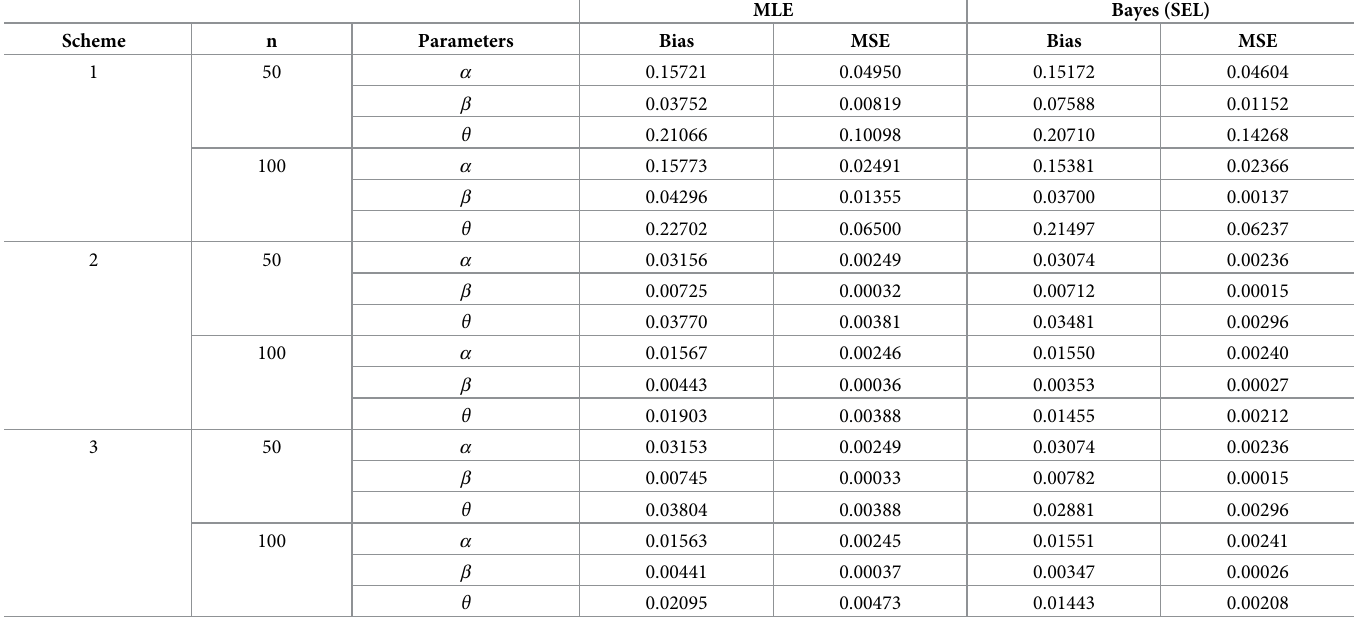
Table 5. MSEs and biases for MLEs and bayes estimators of α = 2.5, θ = 1.5, β =